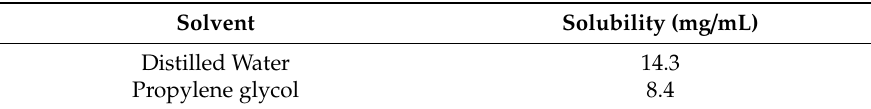
Table 1. Solubility studies for nicotinic acid